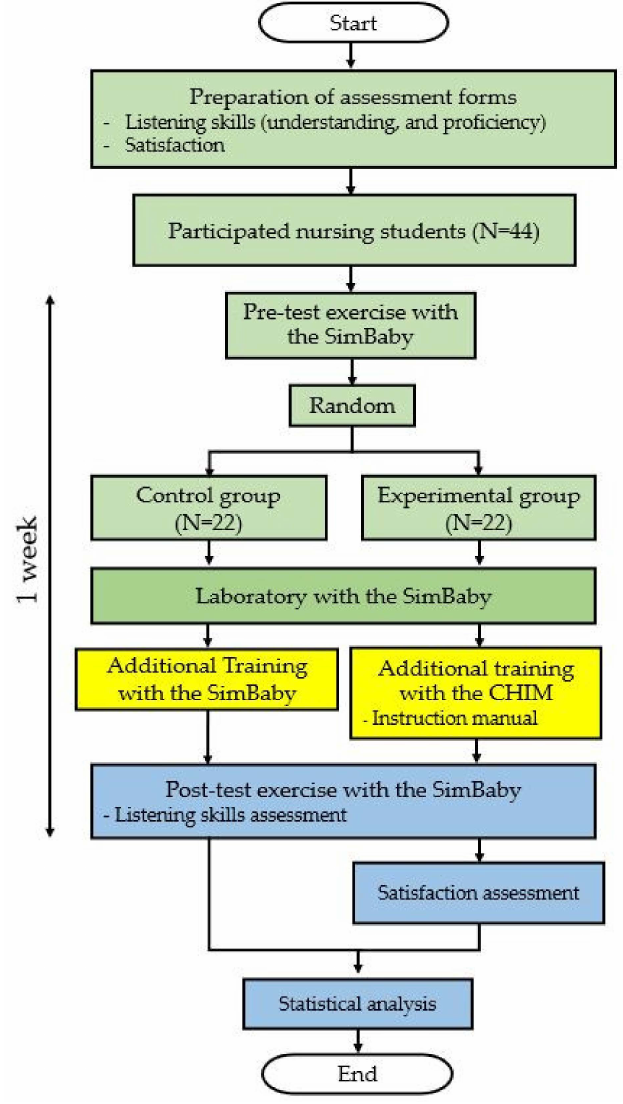
Figure 9. A flowchart of the skills and satisfaction examination